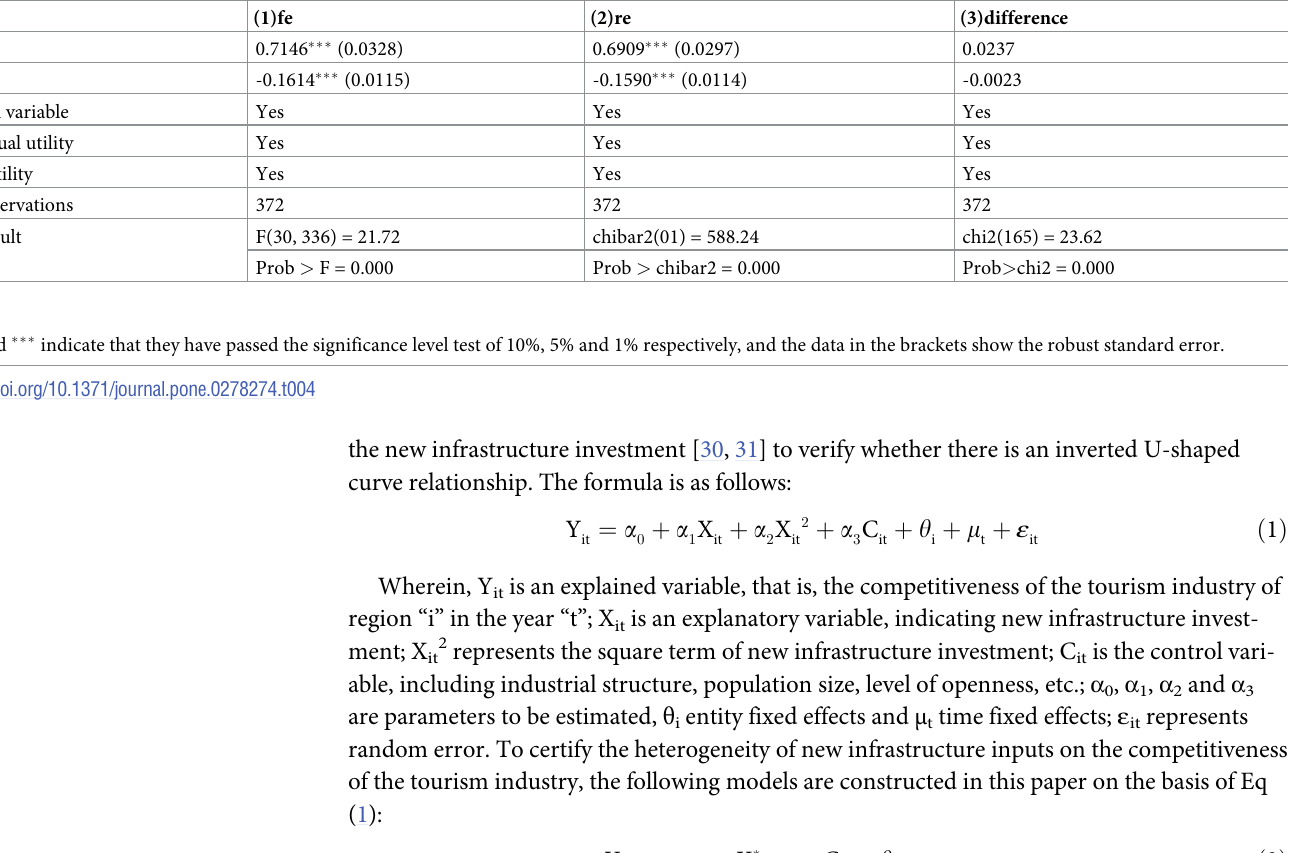
Table 4. Hausman test results. Model